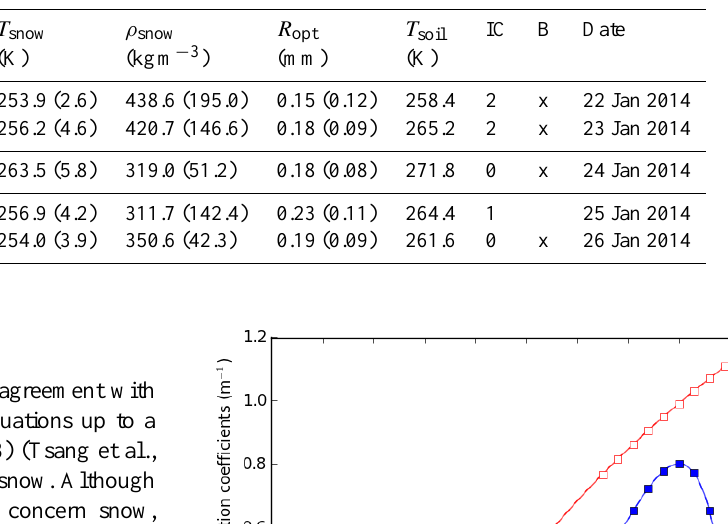
Table 5. Same as Table 1 but for Umiujaq sites (UMI).